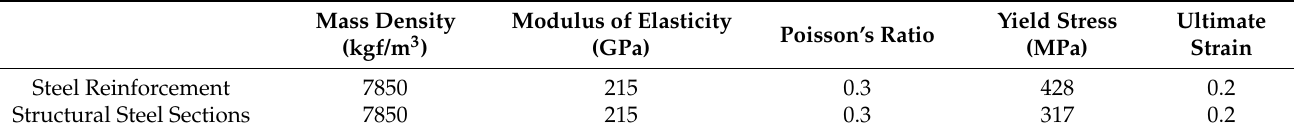
Table 4. Steel reinforcement and structural steel section